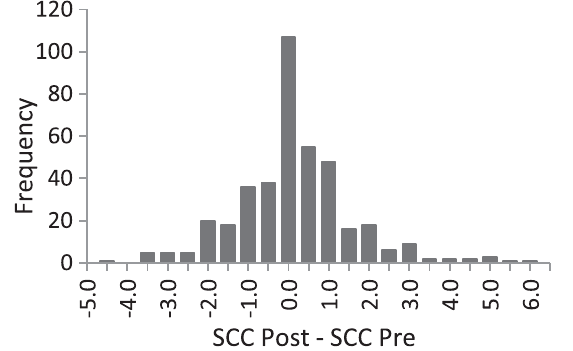
FIG. 2. Histogram of SCC post-SCC prescore differences for all students completing both the pre- and post-SCC. ( N ¼ 392 ).